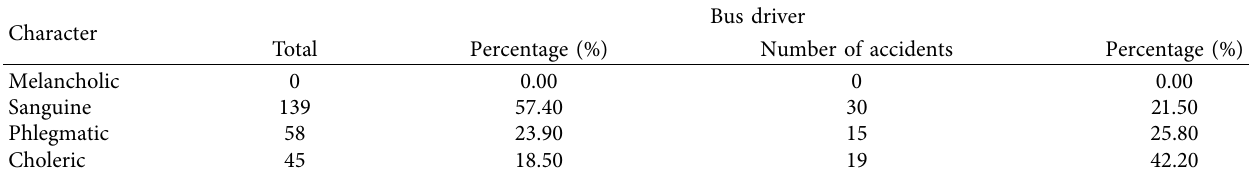
Table 7: Personality distribution.